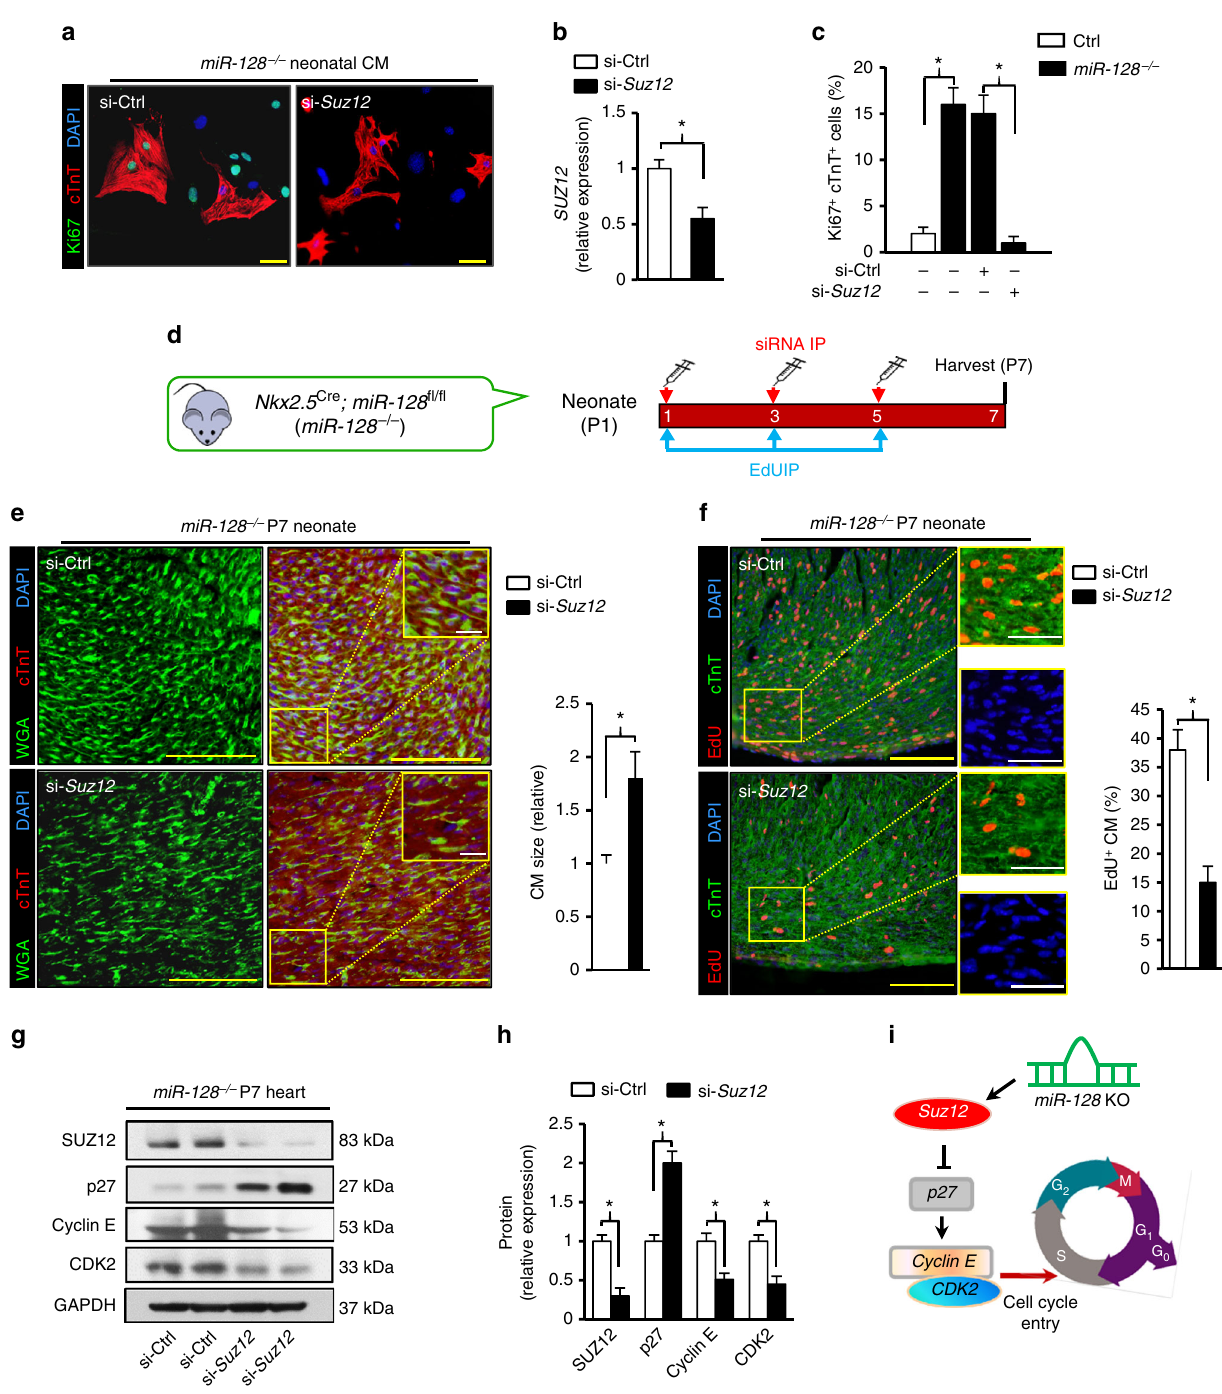
Fig. 5 MiR-128 regulates CM proliferation through targeting Suz12 . a In vitro, evaluation of CM proliferation by immuno fl uorescence staining of Ki67 in miR- 128 − / − ( Nkx2.5 Cre ; miR-128 fl / fl ) neonatal CMs transfected with either scrambled control siRNA (si-Ctrl) or Suz12 siRNA (si- Suz12 ). Cells are counter-stained with DAPI to visualize nuclei and with antibody to cTnT to identify CMs. Scale bars, 40 µ m. b Expression of Suz12 in miR-128 − / − neonatal CMs transfected with either a scrambled control siRNA (si-Ctrl) or Suz12 siRNA (si- Suz12 ) ( n = 5). c Quanti fi cation of CM proliferation by Ki67 immunostaining ( n = 12 samples, ~150 CMs/sample). d Schematic diagram depicting the protocol for siRNA and EdU intraperitoneal (i.p.) injection for P1 mice. e CM size analysis by WGA and cTnT staining in si-Ctrl and si- Suz12 treated miR-128 − / − hearts at P7 ( n = 5 mice, ~300 CMs/heart). Scale bars, 50 µ m (yellow); 10 µ m (white). f Comparison of EdU + CMs in si-Ctrl and si- Suz12 -treated miR-128 − / − hearts at P7 ( n = 5 mice, ~400 CMs/heart).). Scale bars, 50 µ m (yellow), 20 µ m (white). g , h Western blot analysis of cell cycle-related genes in si-Ctrl and si- Suz12 treated miR-128 − / − hearts at P7 ( n = 3). i Proposed model by which miR-128 deletion promotes CM proliferation through coordinating the expression of cell cycle-related genes. Statistical signi fi cance was calculated using Student ’ s t -test in b , c , e , f , and h . Data are represented as means ± SEM. * P <